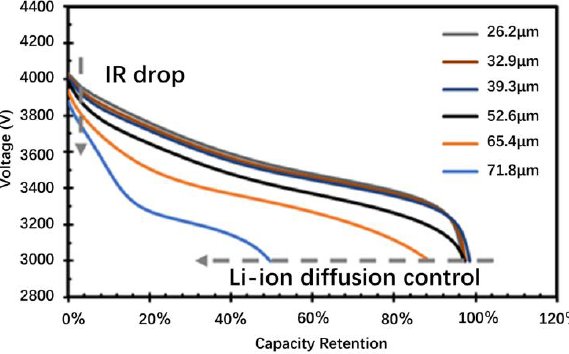
Figure 7. Comparison of discharge curves for the NCM electrode at the rate of 5 C.